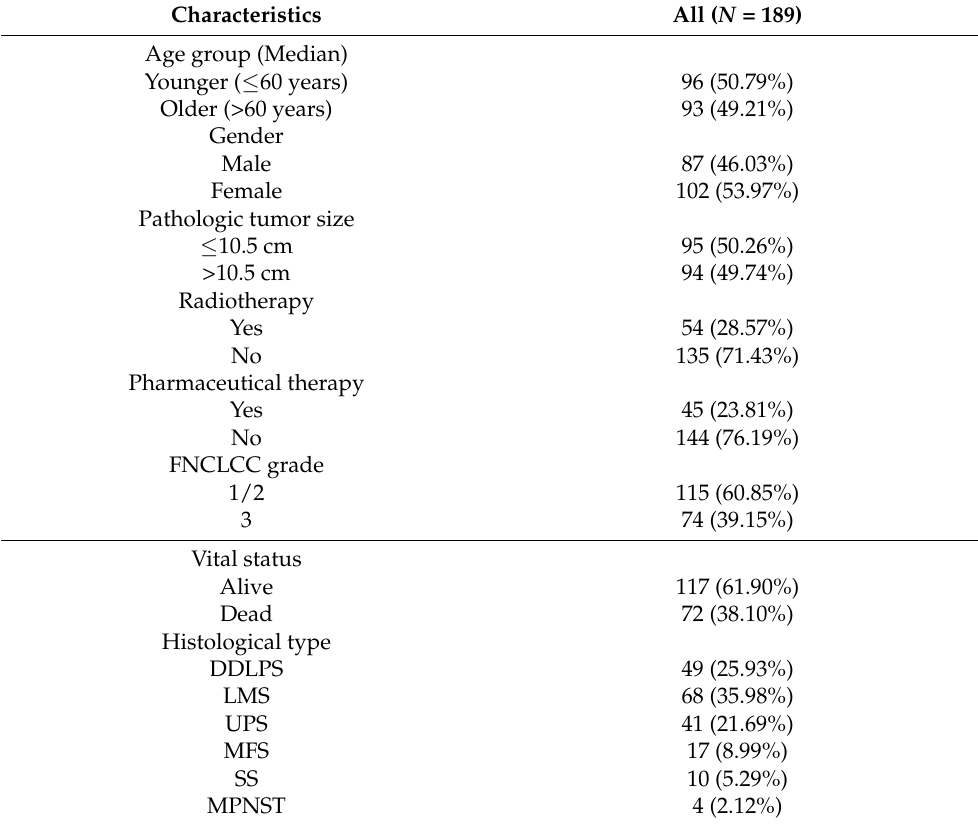
Table 1. Clinical characteristics of included STS